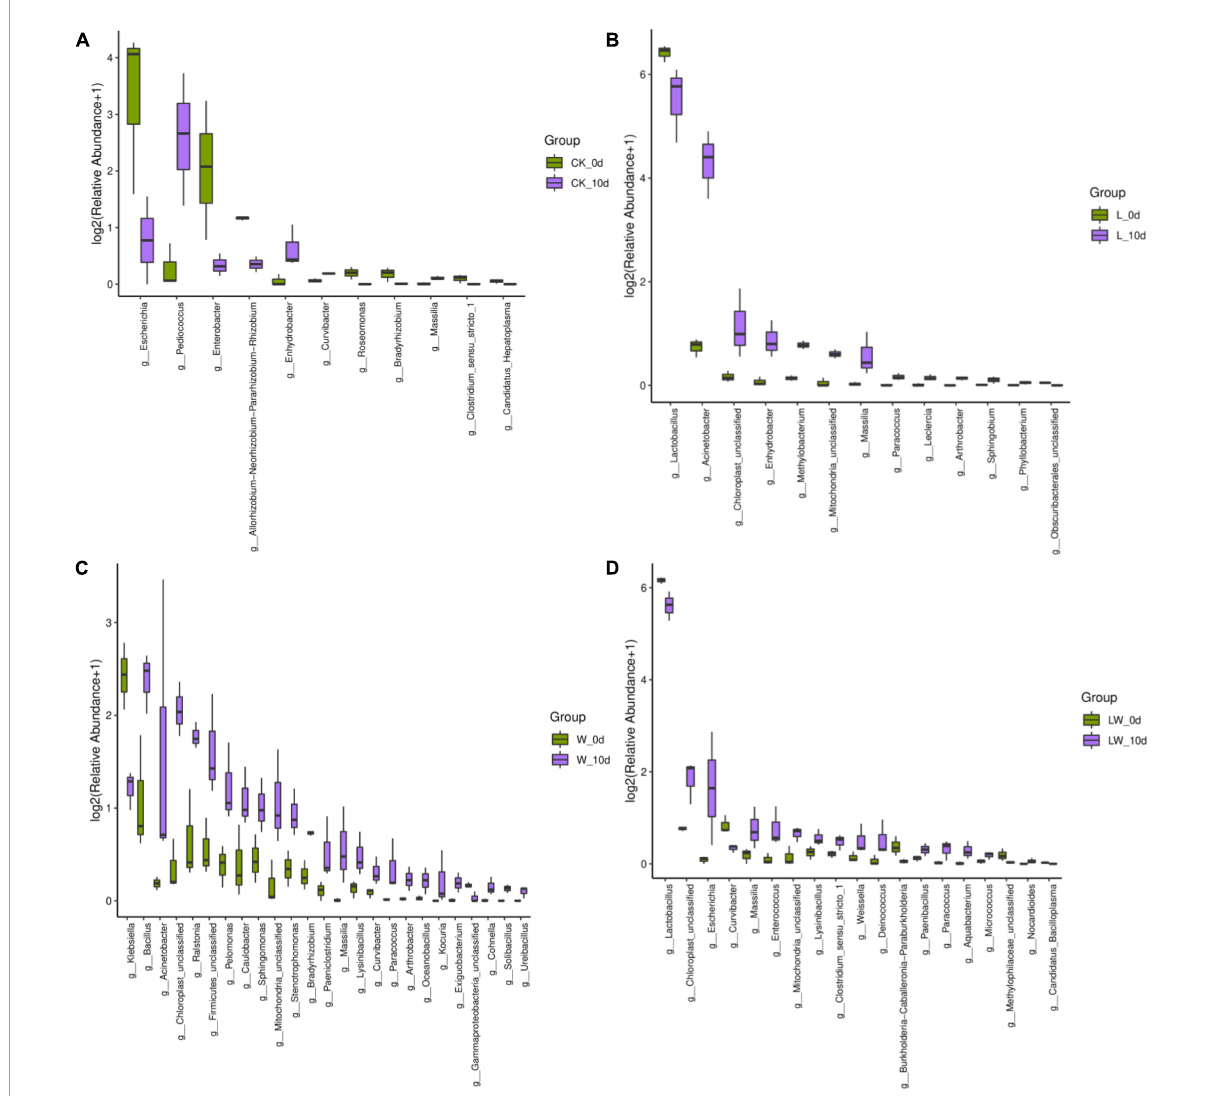
FIGURE4 Difference in bacterial communities (genus level) in Leymus chinensis silages between 0 and 10 days of opening for each treatment ( n = 3). CK (A) , ensiling L. chinensis with 2.00 ml/kg fresh weight (FW) of distilled water; L (B) , ensiling L. chinensis with 2.00 g/t FW of lactic acid bacteria (LAB) inoculant and 2.00 ml/kg FW of distilled water; W (C) , ensiling L. chinensis with 100 ml/kg FW of distilled water; LW (D) , ensiling L. chinensis with 2.00 g/t FW of LAB inoculant and 100.0 ml/kg FW of distilled